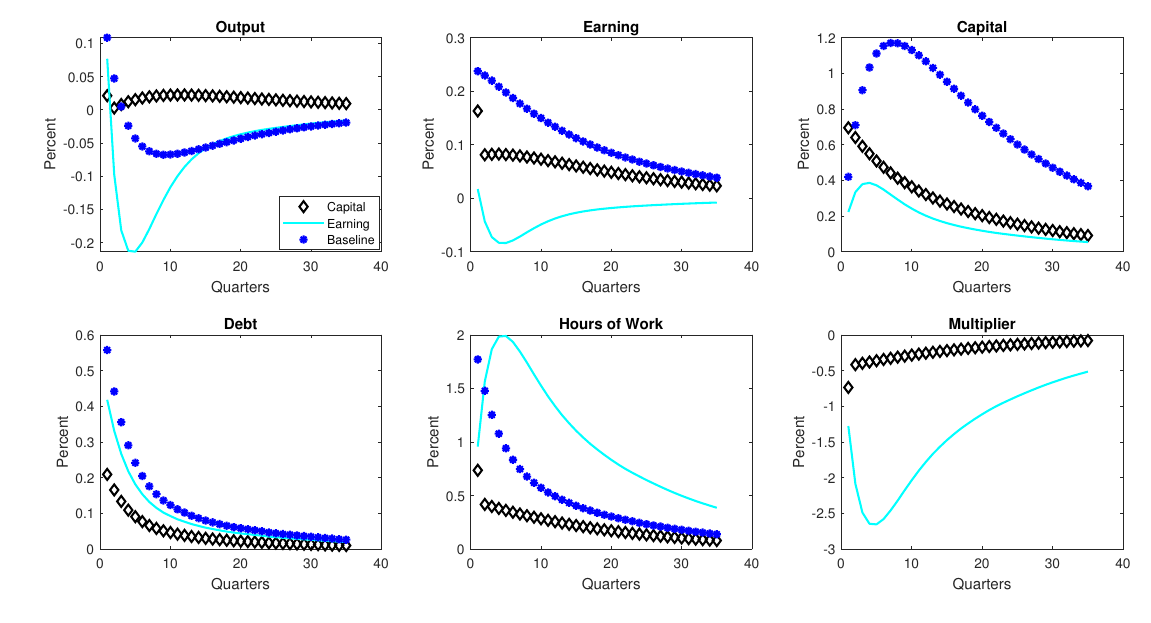
Figure A11. Technology Shock, Earning-Based Borrowing Constraints, and Credit Dynamics. Notes : Figure A11 displays model IRFs of different model variables to technology shocks, under three alternative calibrations in which only the earnings-based constraint (cyan colored lines), only the collateral constraint ( lines with black diamonds), or without any constraints ( impulses with blue stars) is present. The parameters to generate these IRFs are shown in Table 2. We set ρ A = 0.95 and σ A =